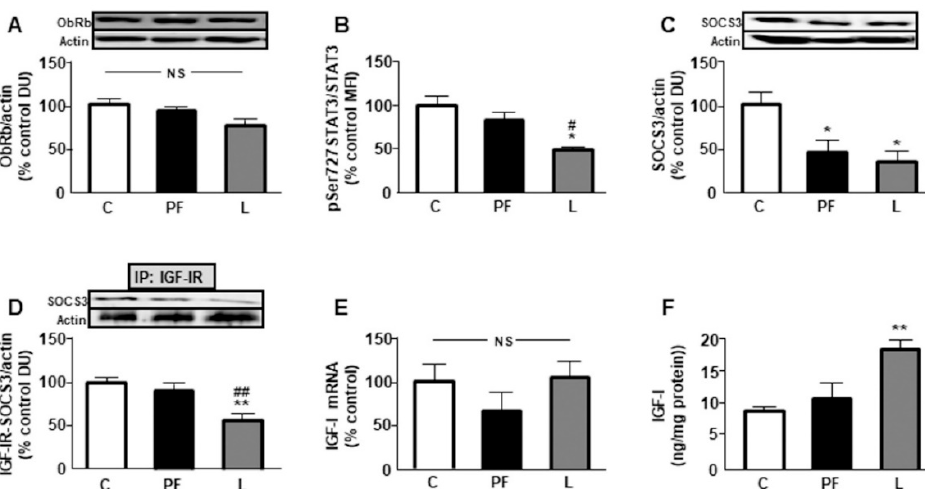
Figure 3. Leptin signaling and IGF-I in brown adipose tissue (BAT). ( A ) Relative protein levels of the long form of the leptin receptor (ObRb), ( B ) phosphorylated (p) signal transducer and activator of transcription 3 at Ser727 (Ser727STAT3), ( C ) suppressor of cytokine signaling-3 (SOCS3), and ( D ) SOCS3 associated to insulin-like growth factor (IGF)-I receptor (IGF-IR) and ( E ) relative IGF-I mRNA content and ( F ) IGF-I concentrations in interscapular BAT of control rats (C), pair-fed rats (PF) and rats receiving a chronic icv leptin infusion (L). Data are presented as means ± SEM. N = 5. DU, densitometry units; IP, immunoprecipitation; MFI, median fluorescent intensity; NS, non-significant. * p < 0.05, ** p < 0.01 vs. C; # p < 0.05, ## p < 0.01 vs. PF.